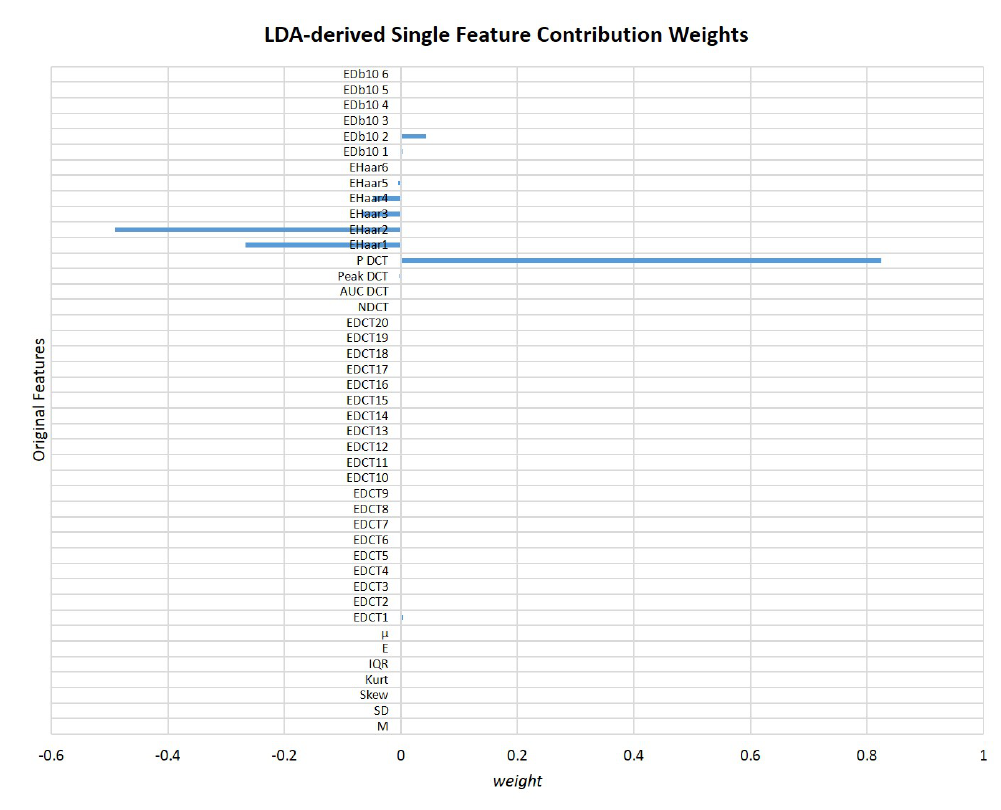
Figure 11. Graphical representation of the contribution weights of each one of the 43 original features for the final LDA-derived single feature (N =